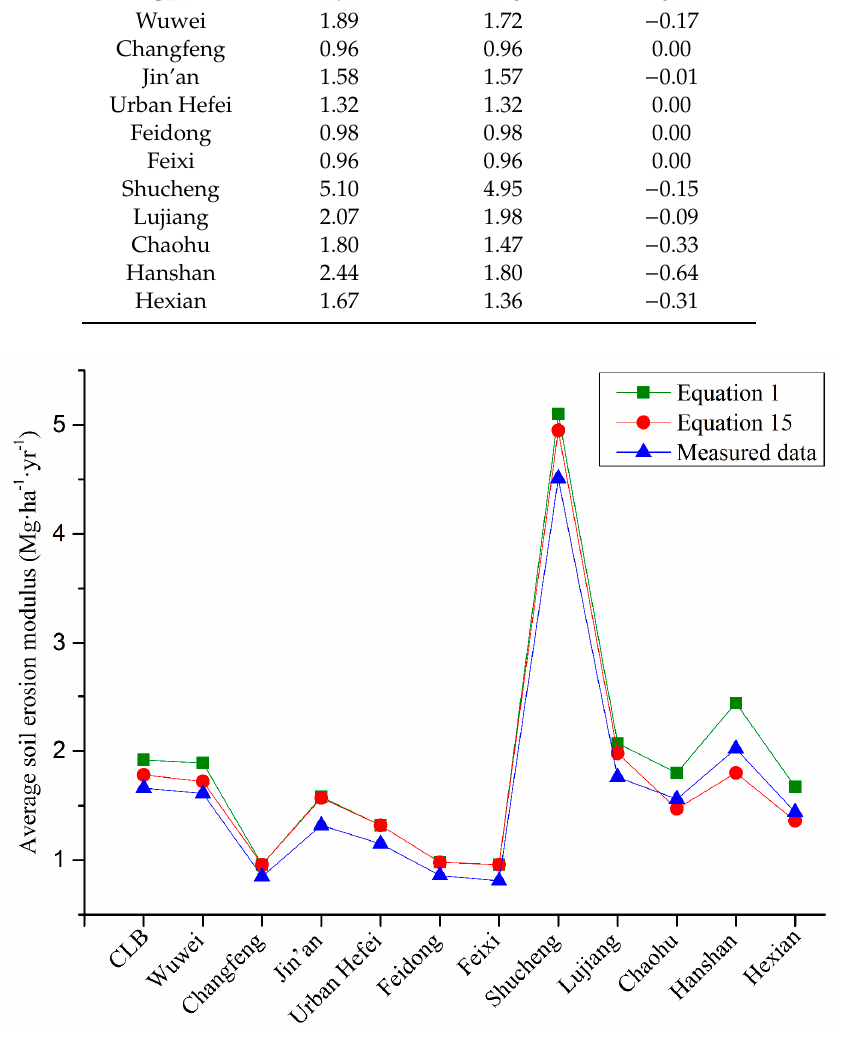
Figure 8. Comparison of the results of Equations (1) and (15) with the measured data.